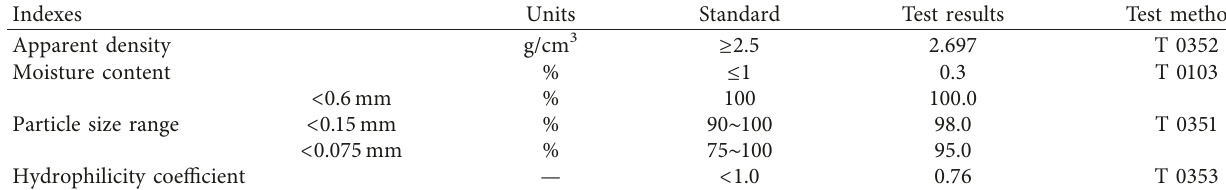
Table 6: The properties of mineral filler.